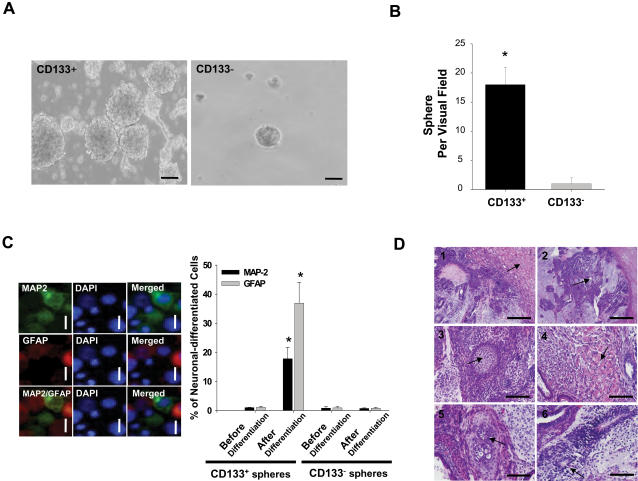
Multi-lineage differentiation capability of CD133+/− AT/RT cells.(A) and (B) sphere formation of CD133+/− AT/RT cells. CD133 cells were cultured in serum free medium with bFGF and EGF (20 ng/mL) for 4 weeks. (C) CD133+ AT/RT cells were cultured for 14 days on a poly-L-lysine coated plate in medium containing 2% FBS. The percentages of MAP-2-positive (MAP-2: neuron marker) and GFAP-positive cells (GFAP: glia marker) were detected in the differentiated CD133+ AT/RT cells. DAPI: staining for cell nuclei (blue fluorescent; bar: 20 µm).*p<0.05. (D) CD133+ AT/RT cells were injected into the subrenal space of a SCID mouse (n = 6). All the mice formed teratomas. (1) arrow: normal kidney tissue of the mouse. The three germ layers include (2) endothelium-like tissues (arrow), (3) epidermoid tissues (arrow), (4) muscle-like tissue (arrow), (5) cartilage-like tissues (arrow), and (6) neuroepithelium-like tissues (arrow); bar: 100 µm. Data shown here are the mean±SD of three experiments.